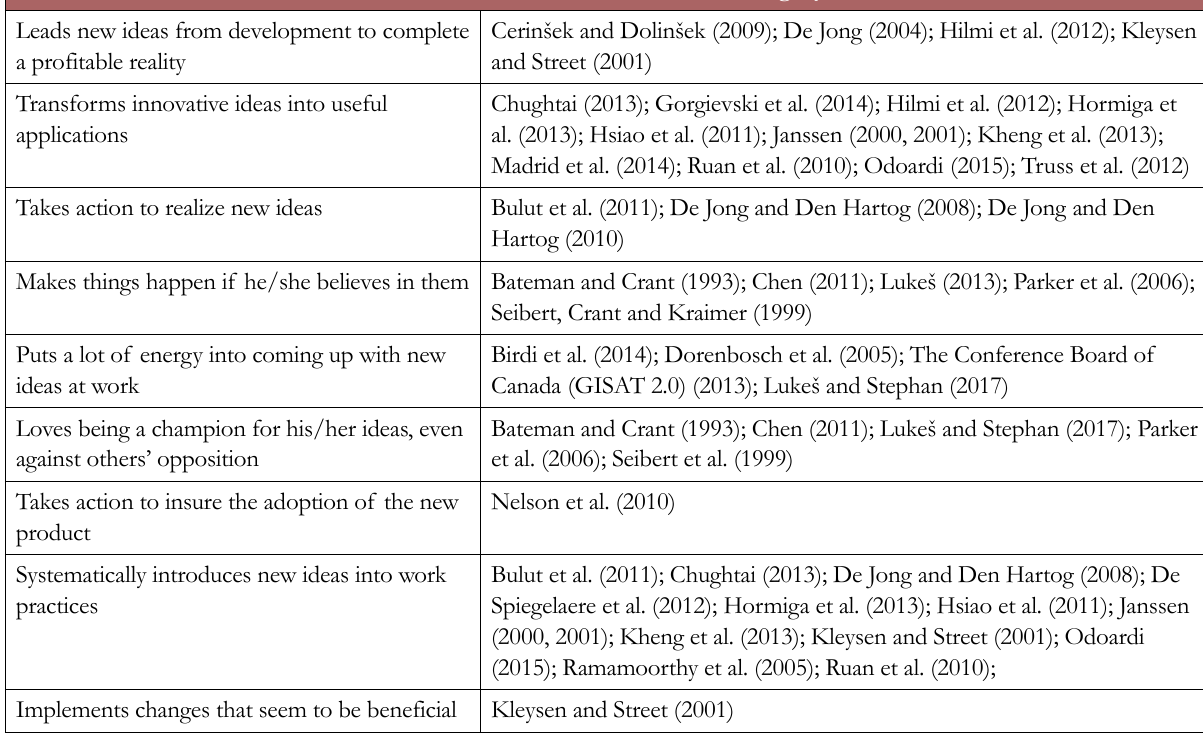
Table 15. Behaviours showing “implementing the ideas”